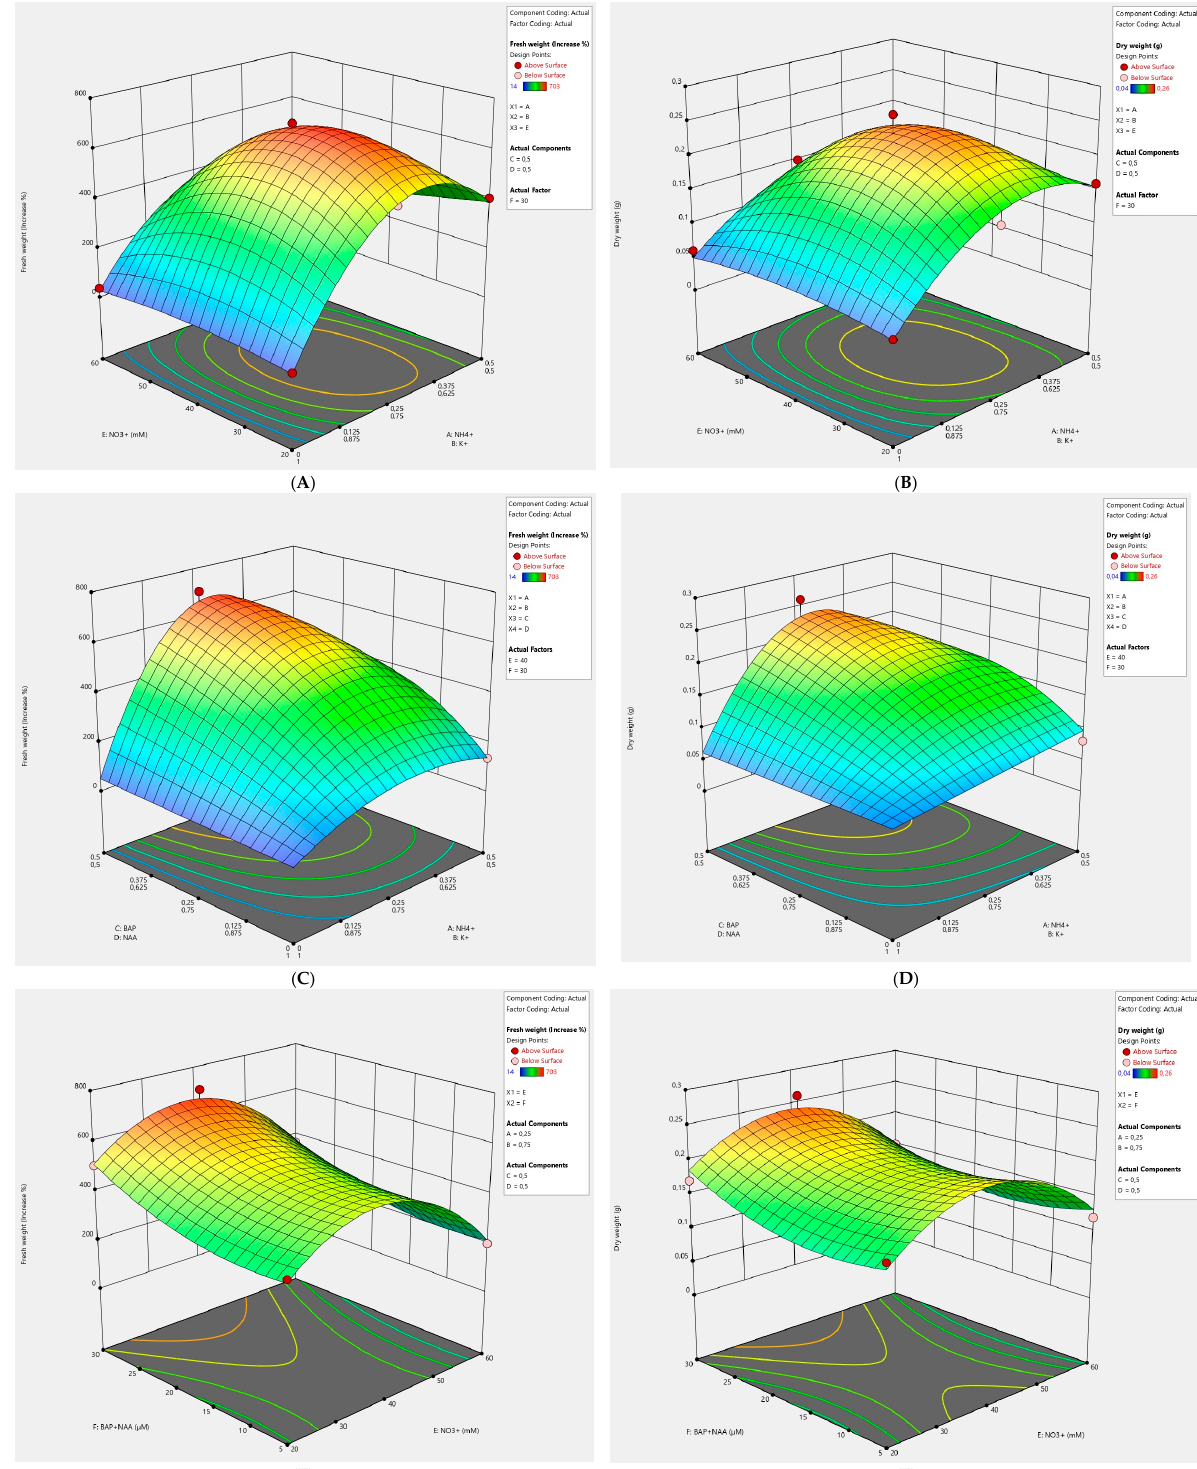
Figure 1. Three-dimensional (3D) response surface plots showing the effects of various factors on R. rosea callus fresh and dry weight. ( A , B ) The impact of the NH 4 + /K + ratio and NO 3 − . ( C , D ) The influence of the BAP/NAA ratio and NH 4 + /K + . ( E , F ) The effect of the concentrations of BAP + NAA and NO 3 −